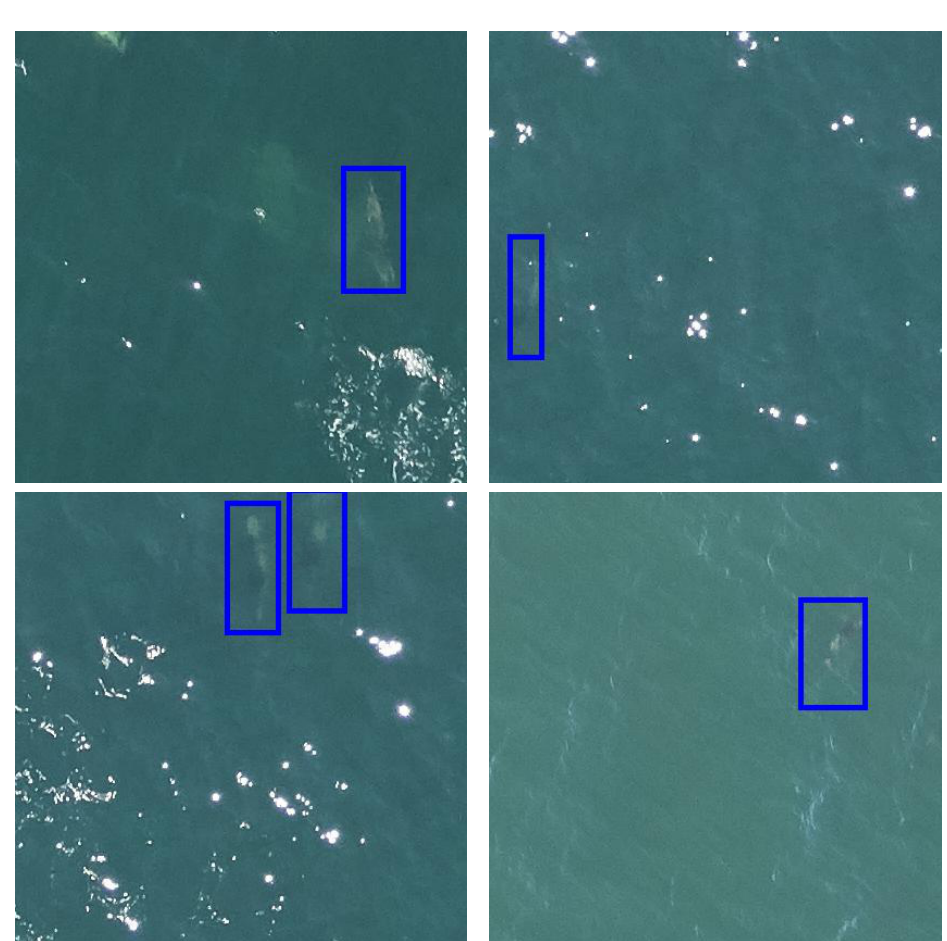
Figure 2. Ground-truth bounding boxes of dolphins with low confidence